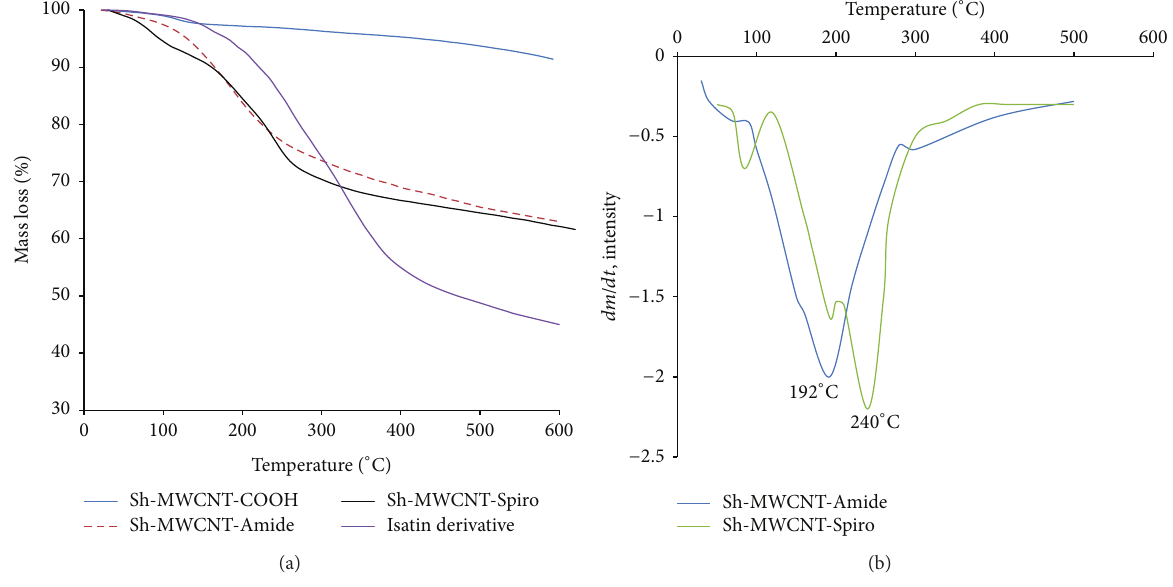
Figure 3: TGA (a) and DTG (b) curves of modified-MWCNTs in the N 2 (10 ∘ Cmin −1 ).